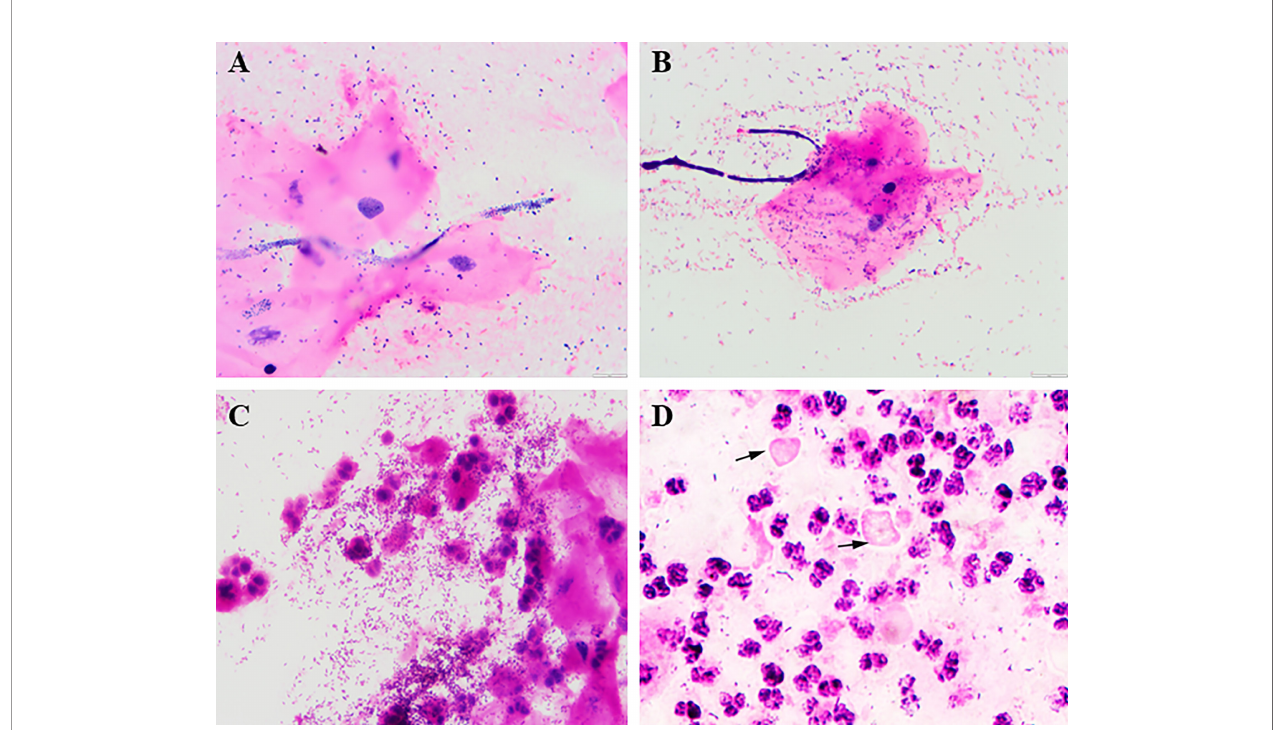
FIGURE 2 | Mixed vaginitis under Gram staining smears (1000×). (A) Candida + coccus ; (B) Candida + BV; (C) BV + in fl ammation; (D) TV + DIV/AV; arrows indicate Trichomonas